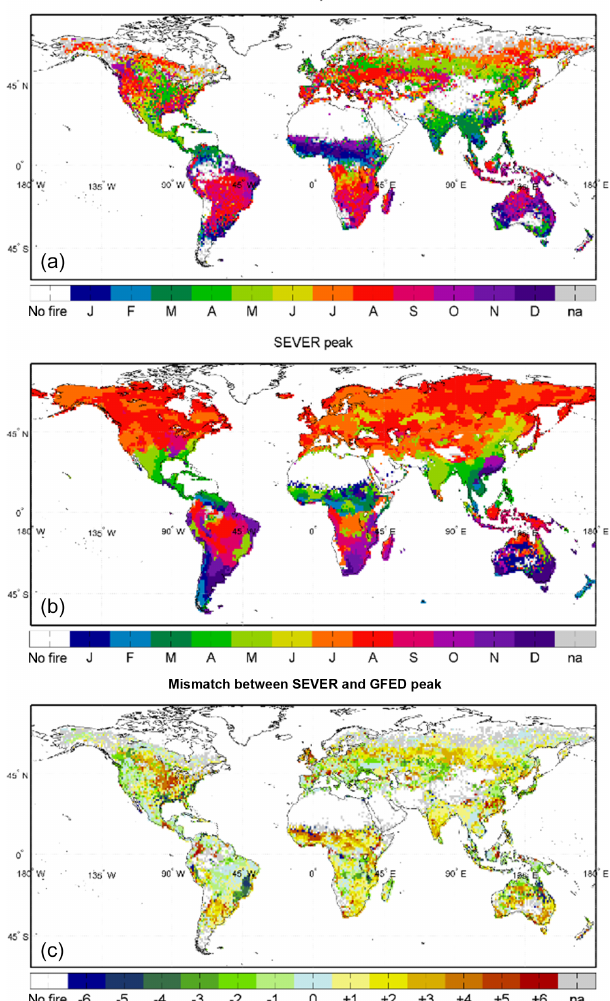
Figure 10. (a) Peak of the fire season in GFED; (b) peak of the fire season in SEVER; (c) relative mismatch between SEVER and GFED peaking month of the fire